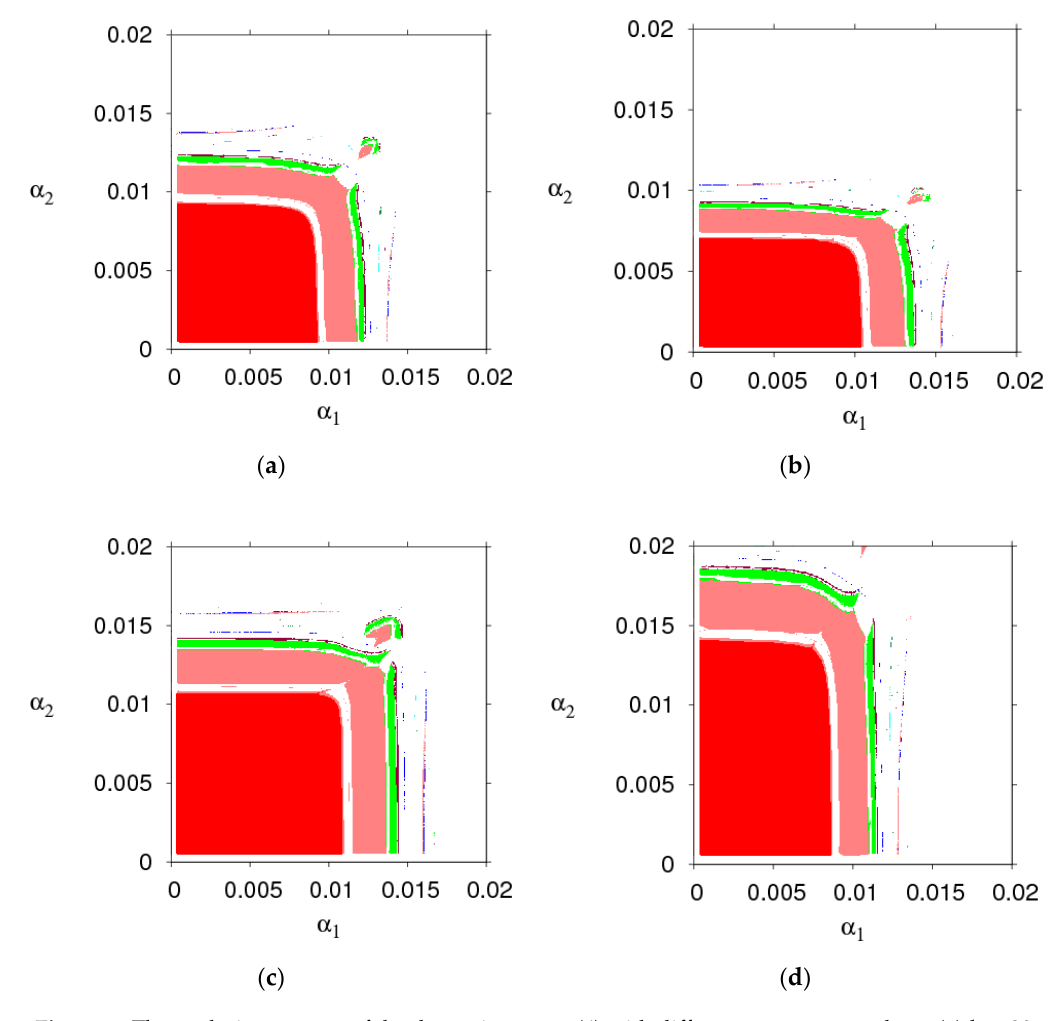
Figure 3. The evolution process of the dynamic system (6) with different parameters values. ( a ) 𝑘 = 20 , ( b ) 𝜆 (cid:2869) = 0.8 , ( c ) 𝜆 (cid:2870) = 0.8 , ( d ) 𝜃 = 0.8